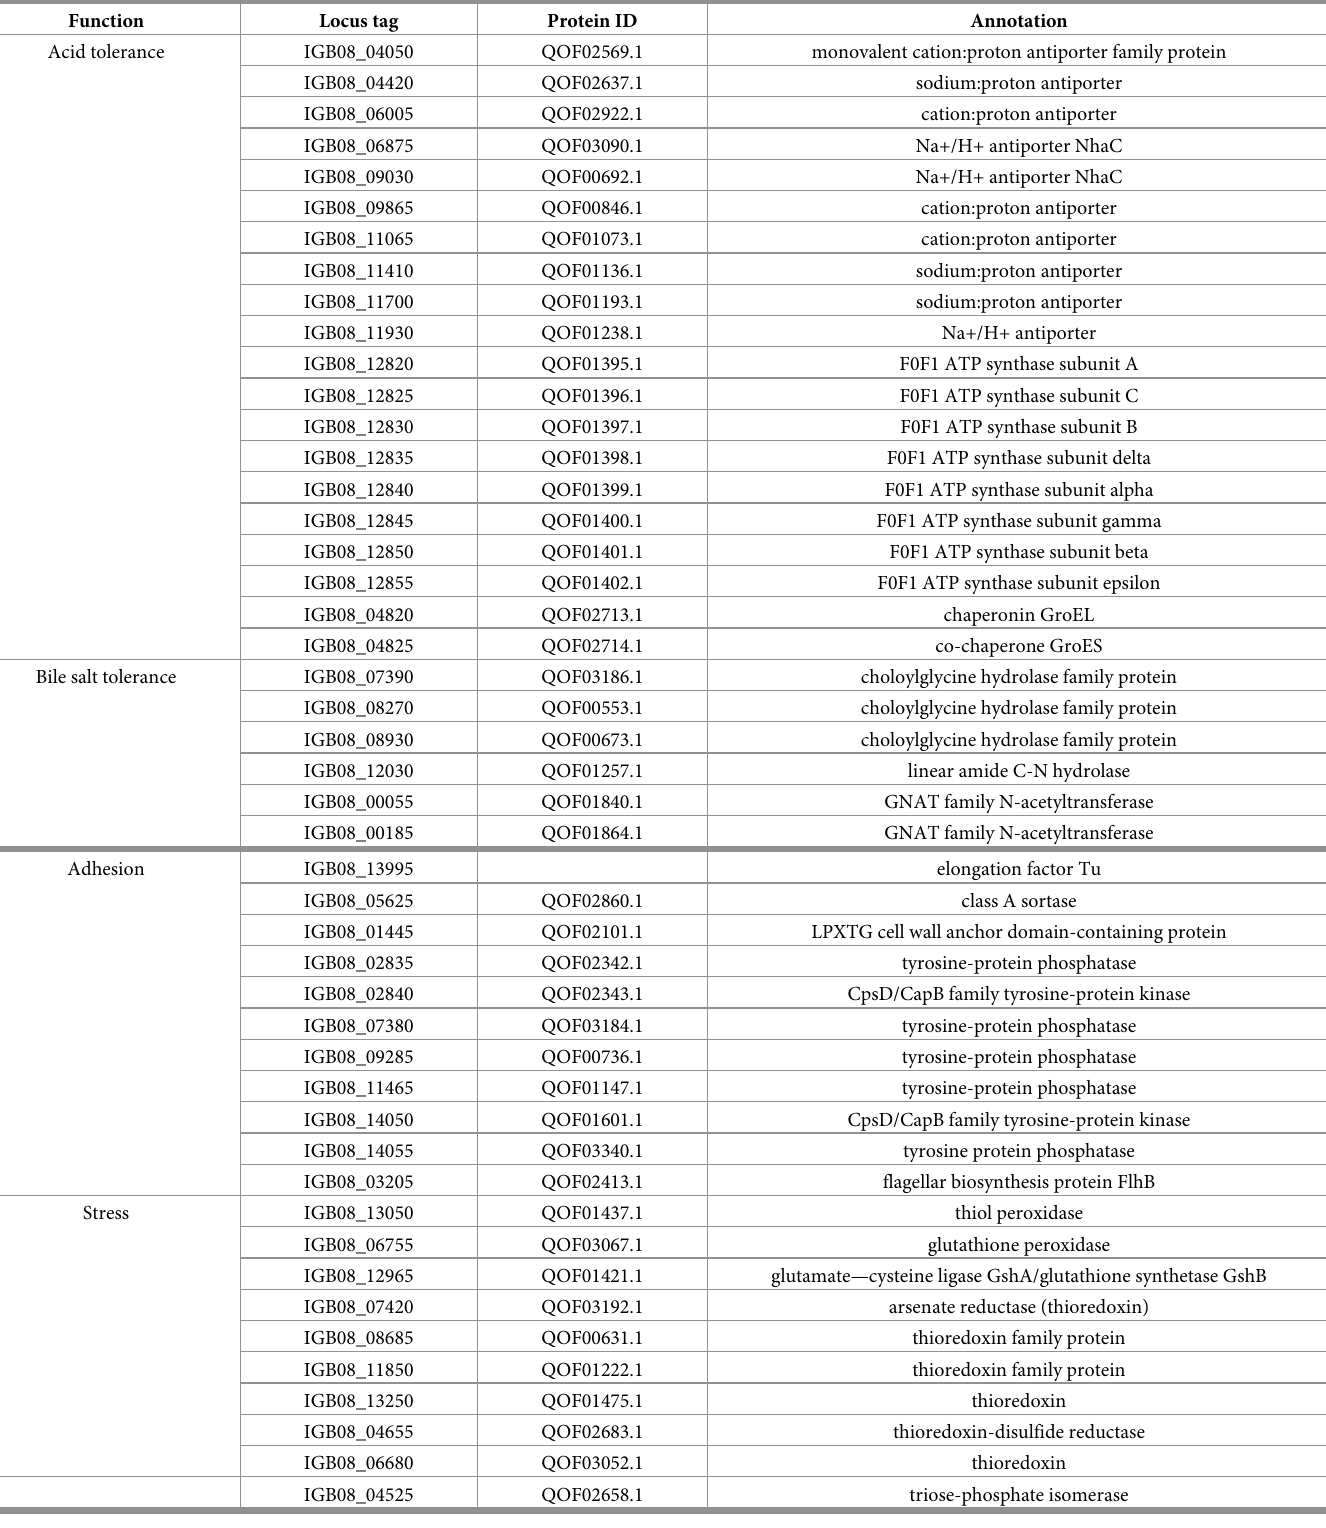
Table 8. Genes related with probiotic characteristics in genome of Lactiplantibacillus plantarum PMO